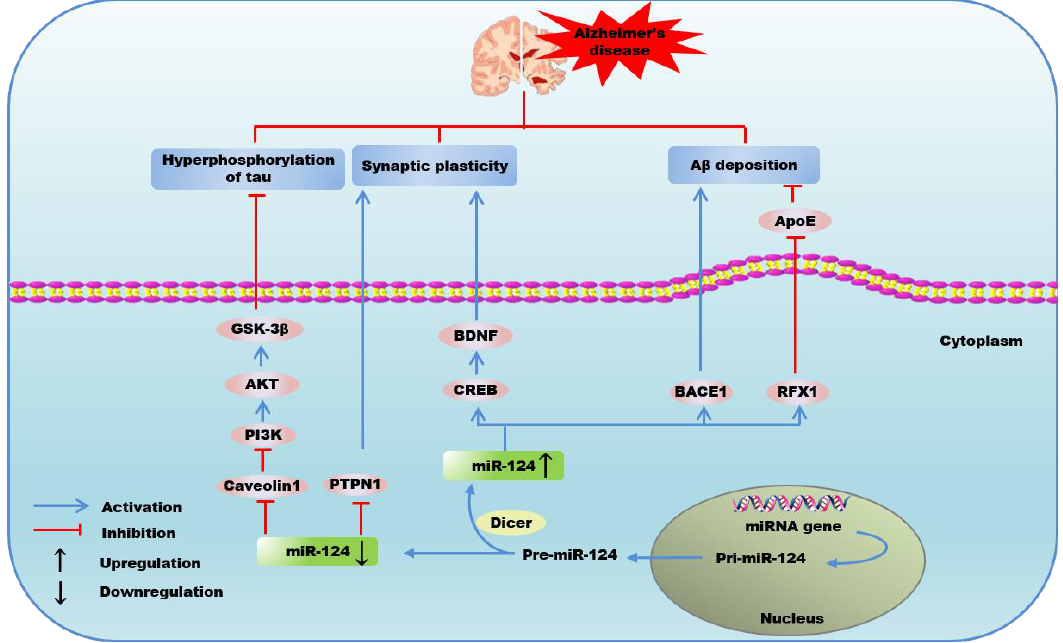
Figure 2. The possible mechanisms of the regulation of microRNA-124 in Alzheimer’s disease.